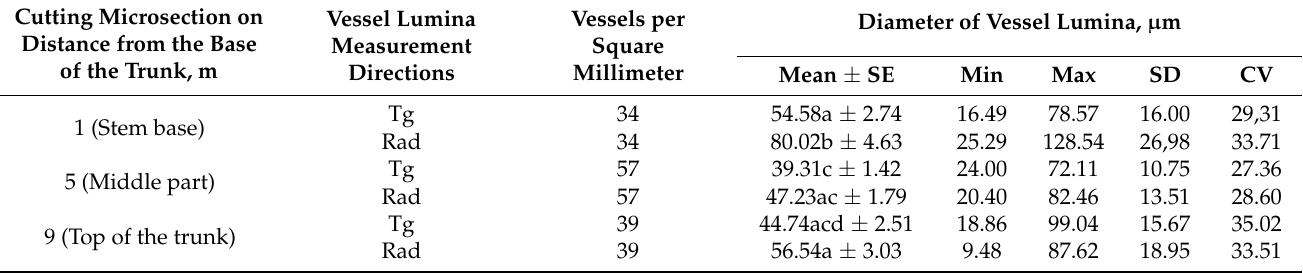
Table 2. Several parameters of vessels of Betula pendula Roth stemwood measured on a transverse microsection depending on the different distances from the base of the trunk.